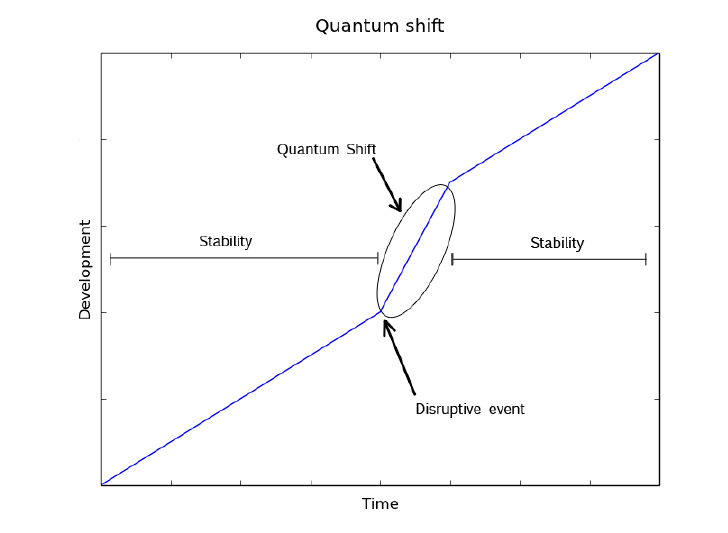
Figure 1. The effects of disruptive events on the operation and development of